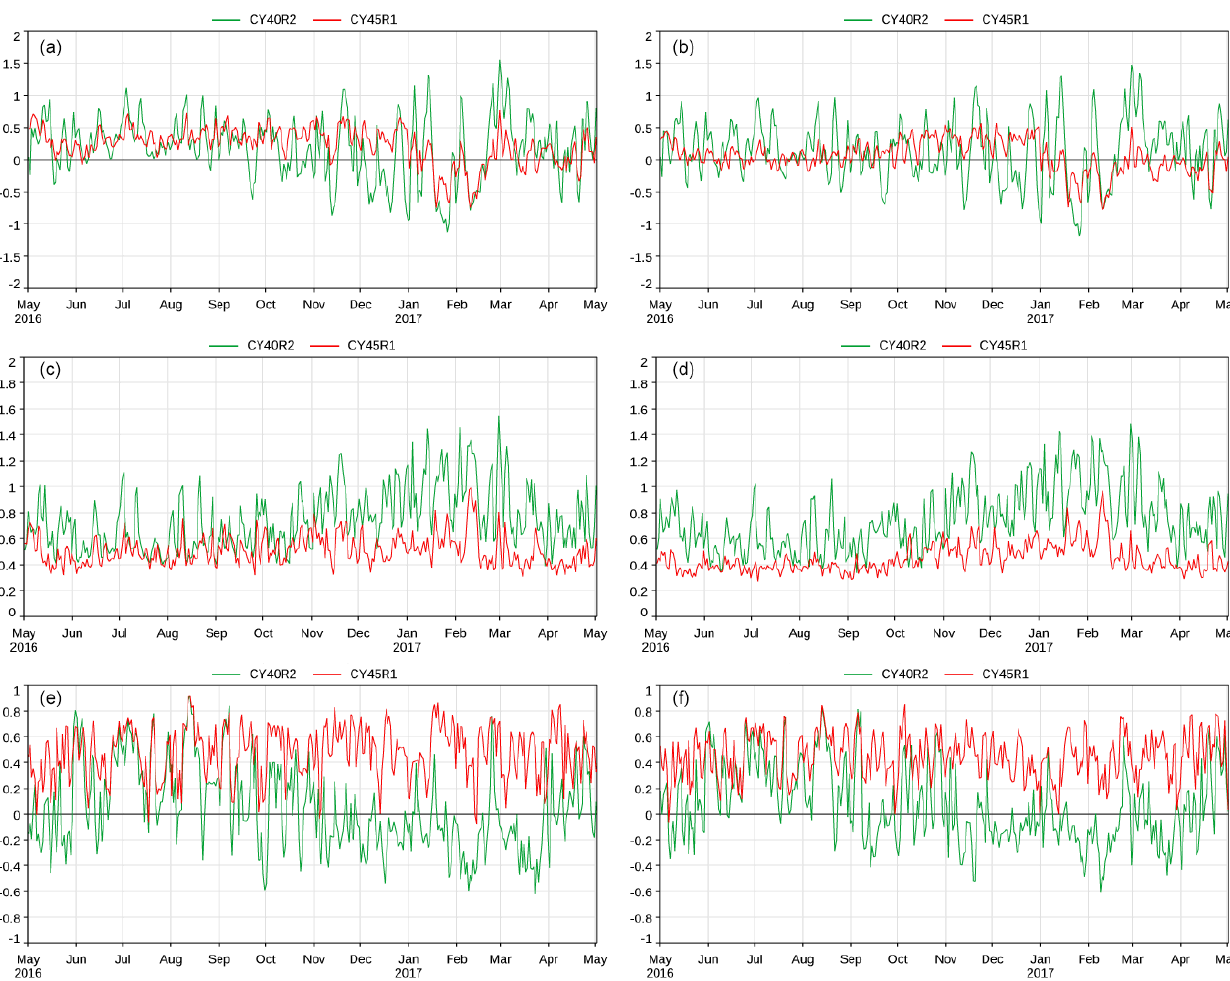
Figure 16. MNMB (a, b) , FGE (c, d) , and spatial correlation (e, f) of daily near-surface PM 2 . 5 (a, c, e) and PM 10 (b, d, f) (µgm − 3 ) simulated by cycles 40R2 (green) and 45R1 (red) against observations of background rural stations in Europe from the AirBase